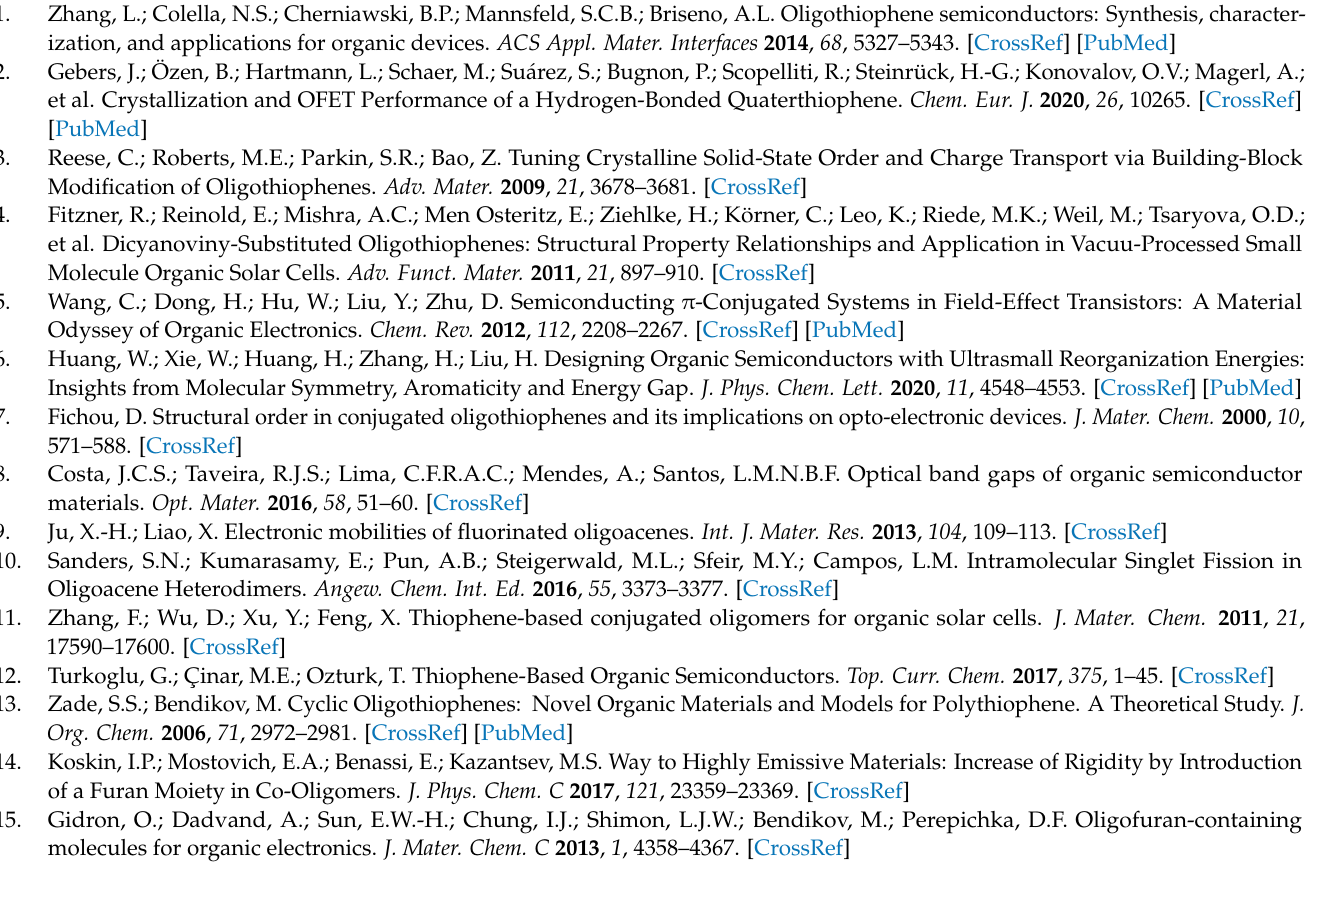
Figure S2: Deviations from the experimental values of the vertical absorption energies calculated using all the studied theoretical methods with the def2-TZVPP basis set; Figure S3: Deviations from the experimental values of the vertical emission energies calculated using all the studied theoretical methods with the def2-TZVPP basis set; Figure S4: Deviations from the experimental values of the averaged reorganization energies: 0.5 ∗ ( λ gr + λ ex ), calculated using all the studied theoretical methods with the def2-TZVPP basis set. The experimental reference values have been estimated as 0.5 ∗ ( E v.abs. − E v.em. ); Figure S5: Comparison of the absorption and emission spectrum of 2O obtained at the CC2/def2-TZVPP level of theory with and without the Dushinsky rotation of the normal